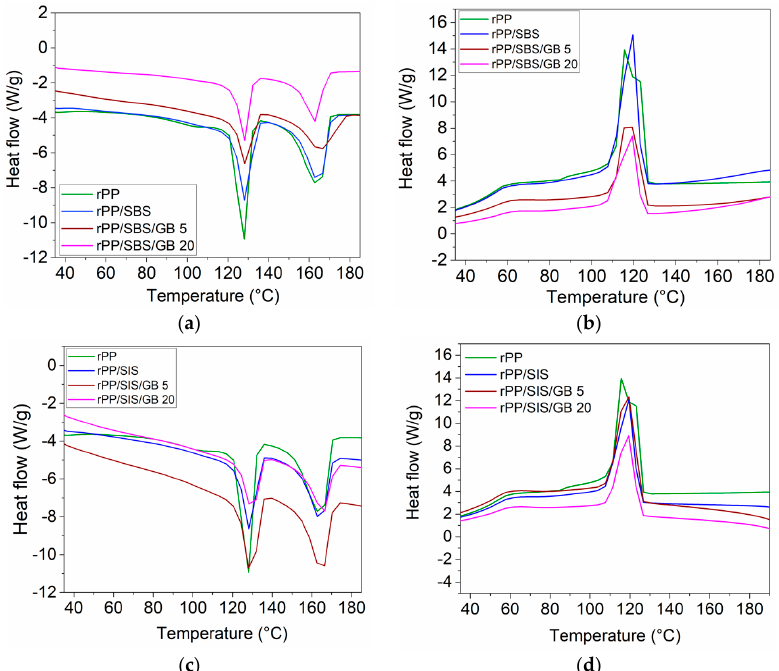
Figure 5. Di ff erential scanning calorimetry (DSC) curves for rPP / SBS / GB and rPP / SIS / GB composites: ( a , b ) Second heating run; ( c , d ) Re-crystallization during